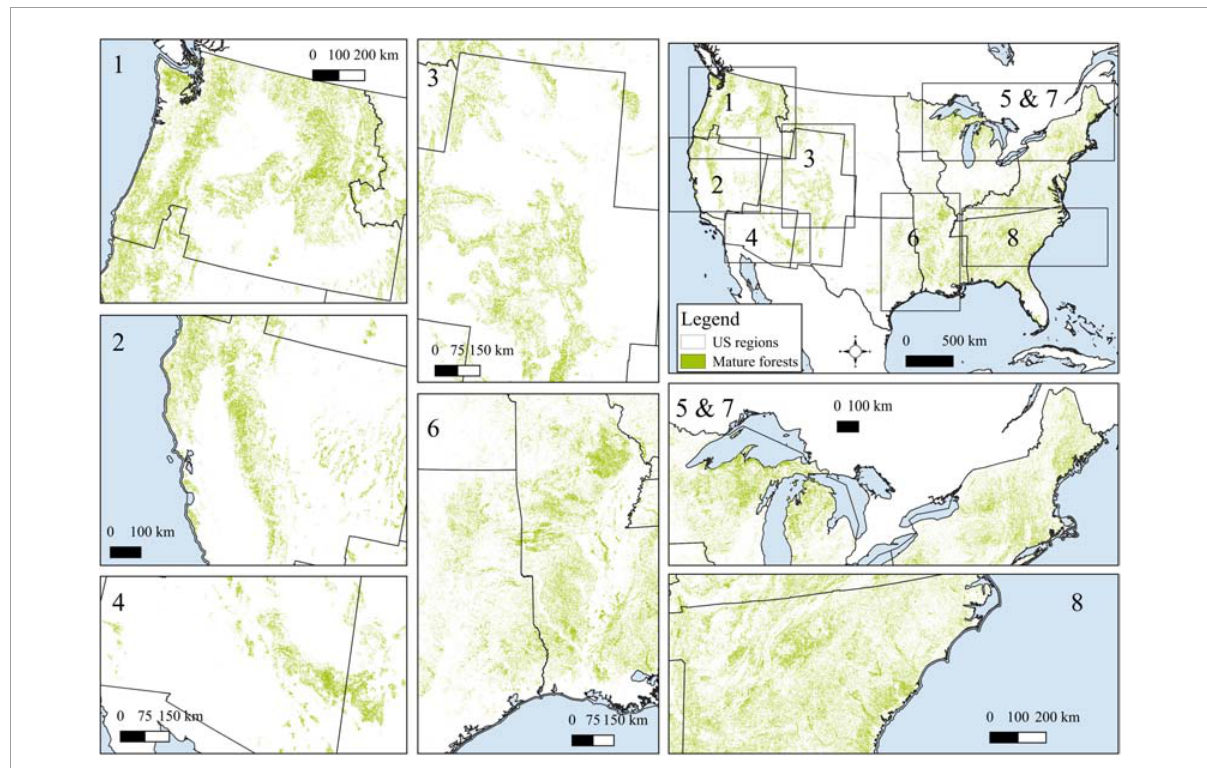
FIGURE3 Regional zoom-ins of mature and old-growth forests of the conterminous United States. Panels show Pacific Northwest (1), Pacific Southwest (2), Rockies (3), Southwest (4), Great Lakes (5), South Central (6), Northeast (7), and Southeast